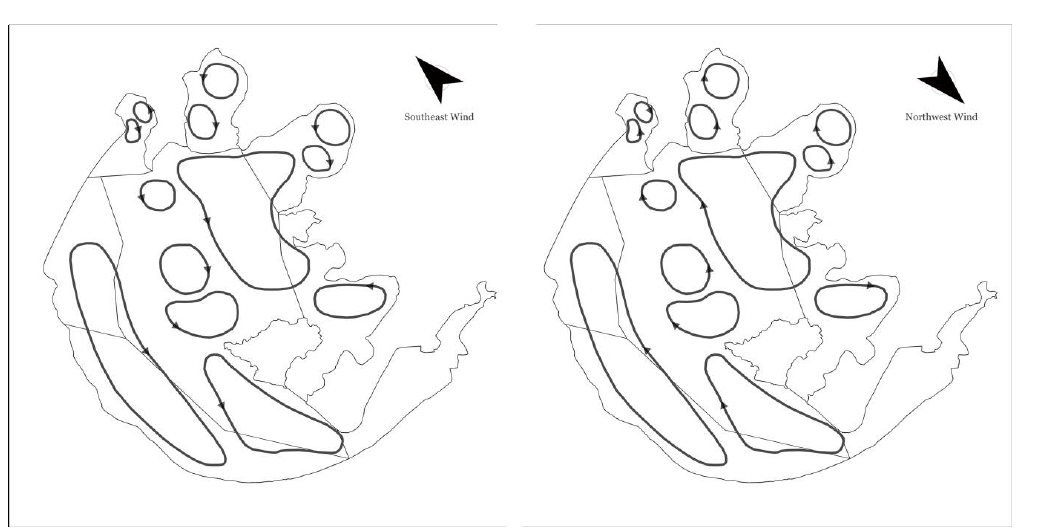
Figure 4. Depth-averaged circulation gyres for northwest and southeast wind.